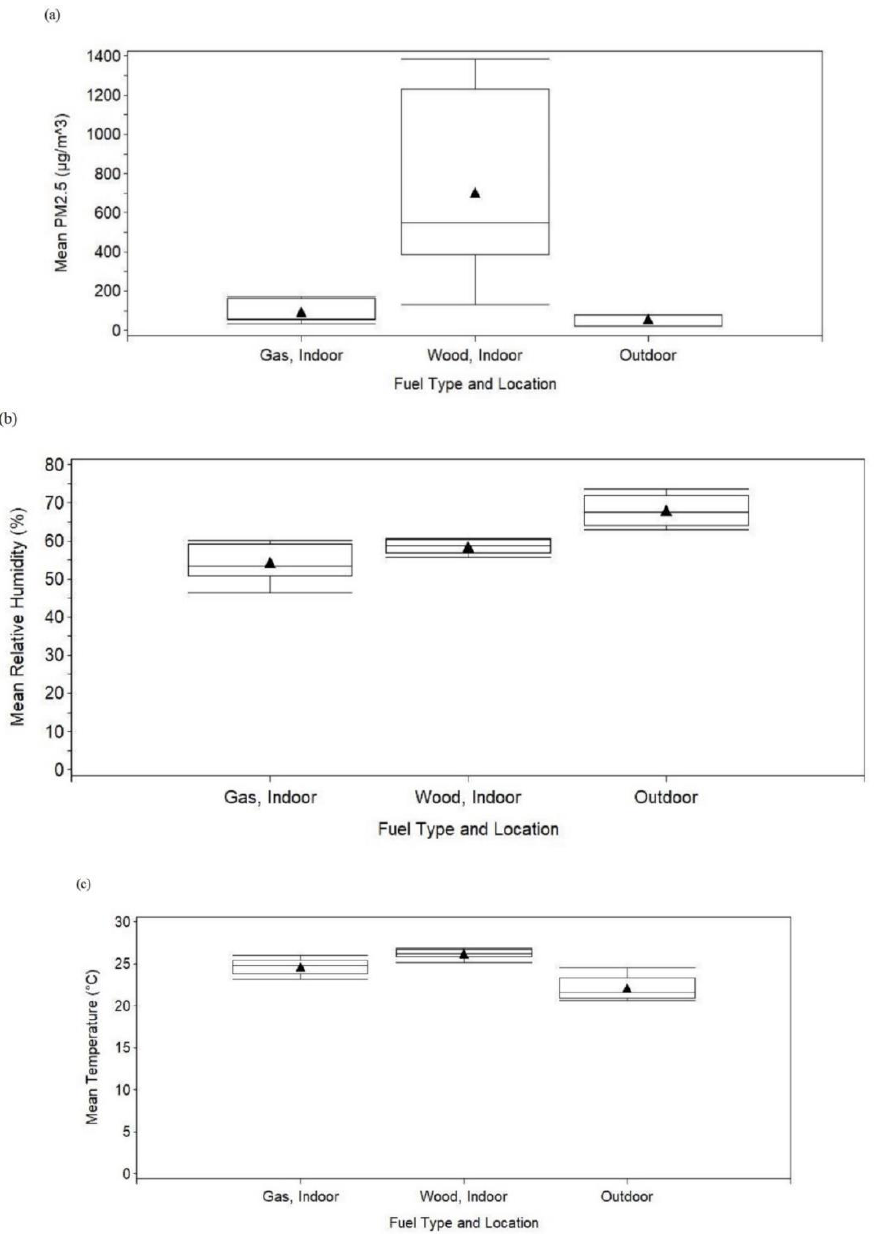
Figure 3. Box plots of the mean of samples inside or outside a homes by fuel type and location at a brick kiln in Bhaktapur, Nepal, May 2019: ( a ) PM 2.5 , ( b ) relative humidity, ( c ) temperature. Reading from the top to the bottom, the horizontal lines on each box plot represent the maximum, third quartile, median, first quartile, and minimum, and the black triangle represents the mean. Abbreviation: PM 2.5 , particulate matter with an aerodynamic diameter less than 2.5 µ m. a Nineteen samples were from inside and four samples were from outside the homes (for PM 2.5 , 17 samples were from inside and three samples were from outside the homes).